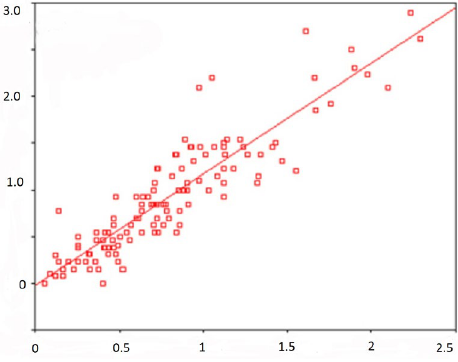
Figure 2. Scatter diagram. Note: Along the ordinate axis is the depression scale (in points); along the abscissa axis is the general severity index (in points).